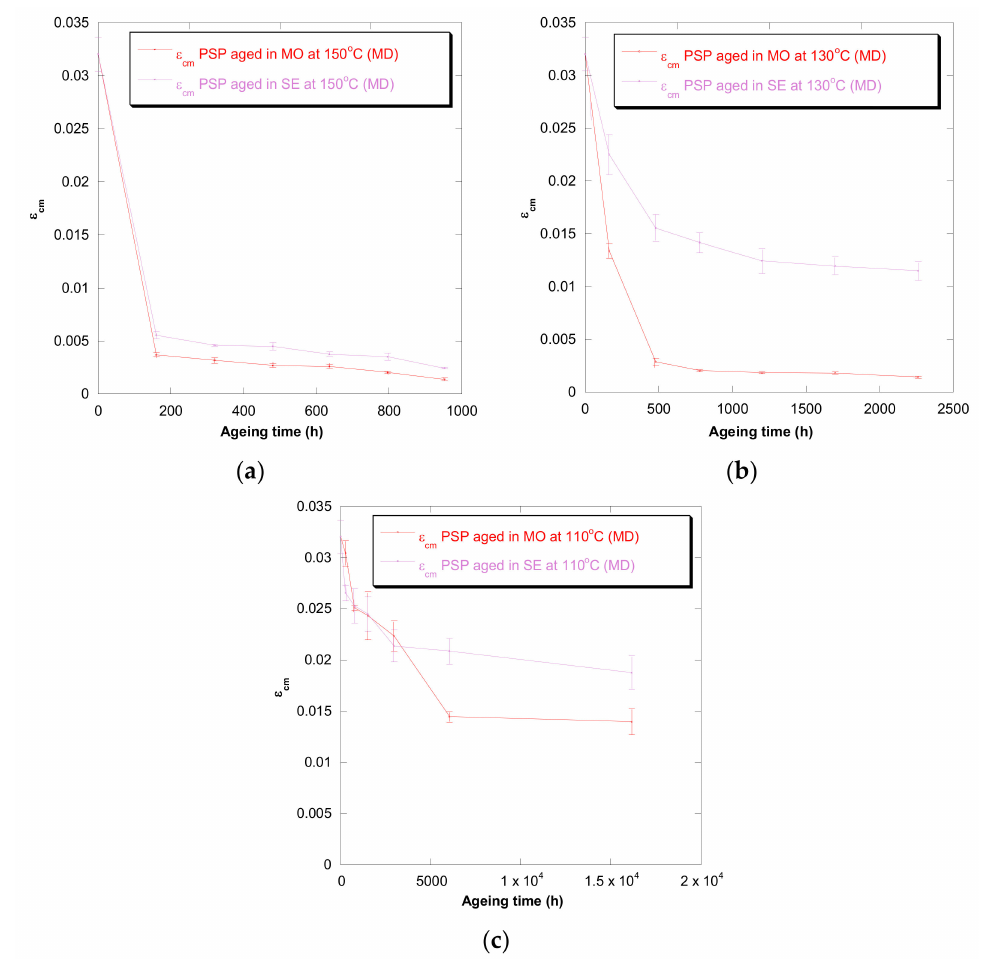
Figure 4. Evolution of the ε cm in MD as a function of temperature for cellulose-board PSP 3055 aged in mineral oil and in synthetic ester at 150 ◦ C ( a ), 130 ◦ C ( b ), and 110 ◦ C ( c